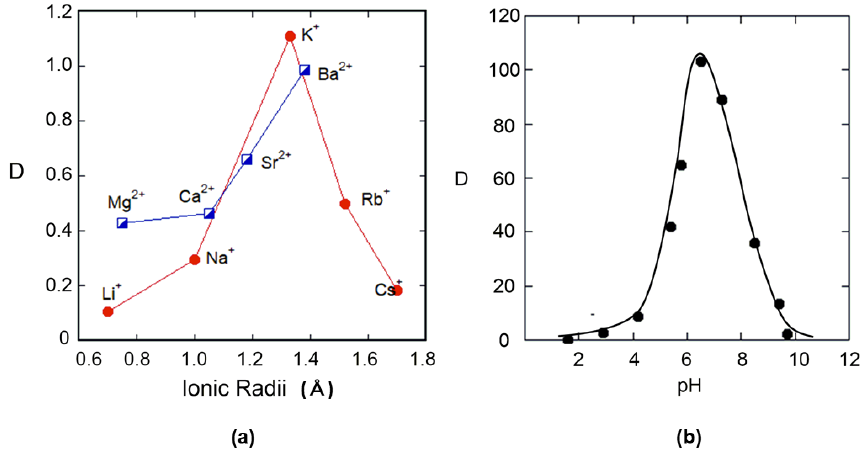
Figure 9. ( a ) Distribution ratios (%) of alkali and alkali earth metal cations. ( b ) Plots of distribution ratios (%) of UO 22+ vs. pHs of aq. phase.